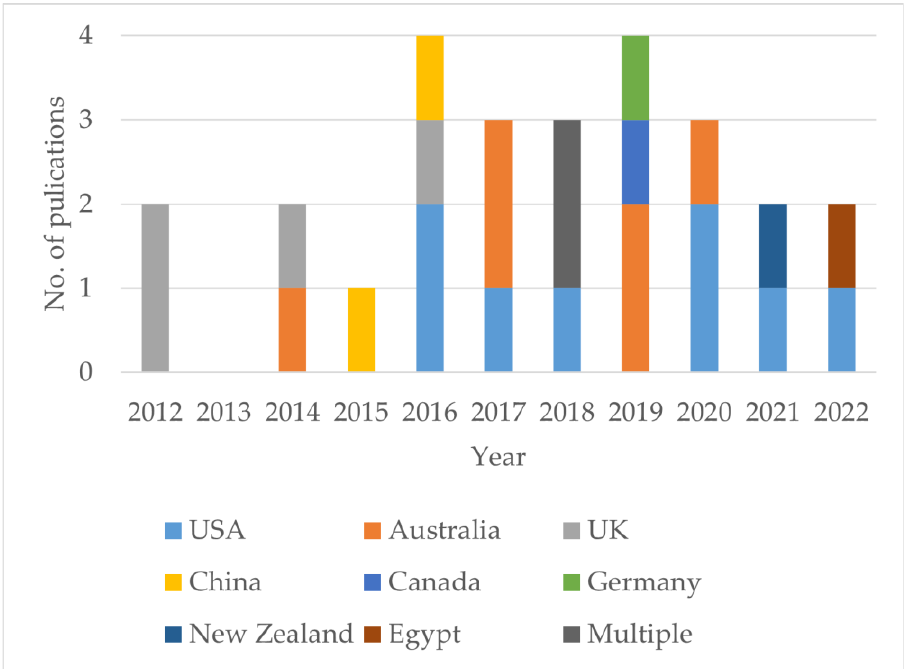
Figure 2 . Paper distribution by year and focused geographic region . Figure 2. Paper distribution by year and focused geographic